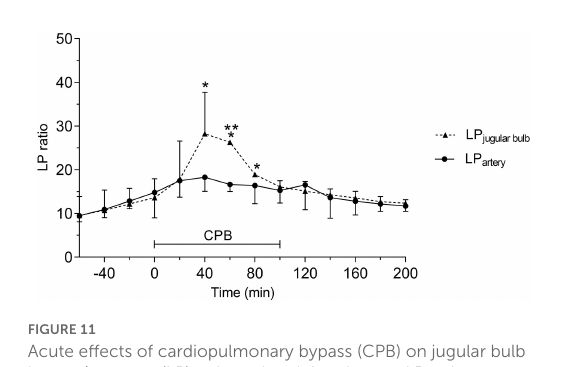
FIGURE11 Acute effects of cardiopulmonary bypass (CPB) on jugular bulb lactate/pyruvate (LP) ratio and peripheral artery LP ratio. * Significant difference from baseline. ** Significant difference between corresponding datapoints by one-way analysis of variance and corrected for multiple comparisons using the Bonferroni test ( α = 0.006). Values are median and error with inter quartile range ( n = 10). Figure by permission from